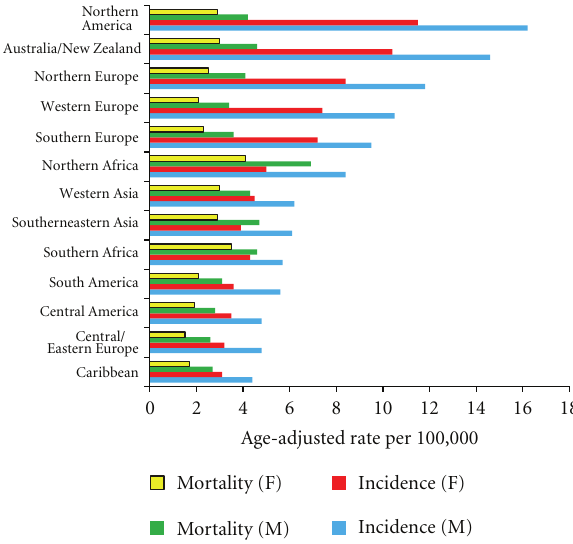
Figure 2: Age-adjusted incidence and mortality rates of non- Hodgkin lymphoma in selected world regions based on IARC GLOBOCAN 2008